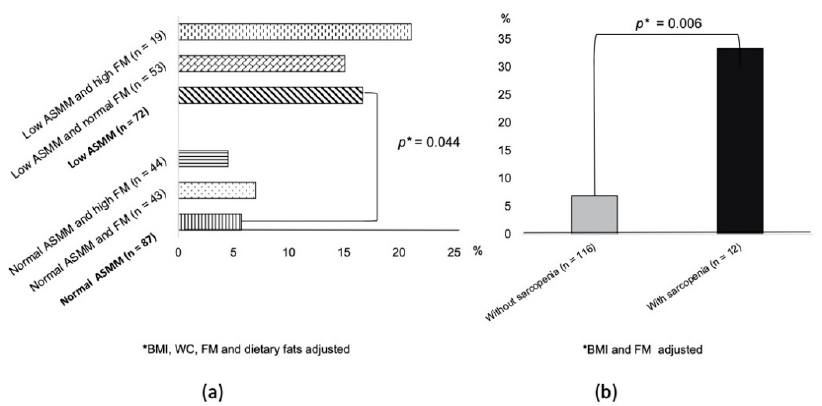
Figure 3. Incidence of impaired fasting glucose/type 2 diabetes according to appendicular skeletal muscle mass and fat mass categories ( a ) or the presence of sarcopenia ( b ). The OR of low ASMM for IFG/T2D onset was 3.81 (SE 0.55, p = 0.034, CI = 1.09–9.80).